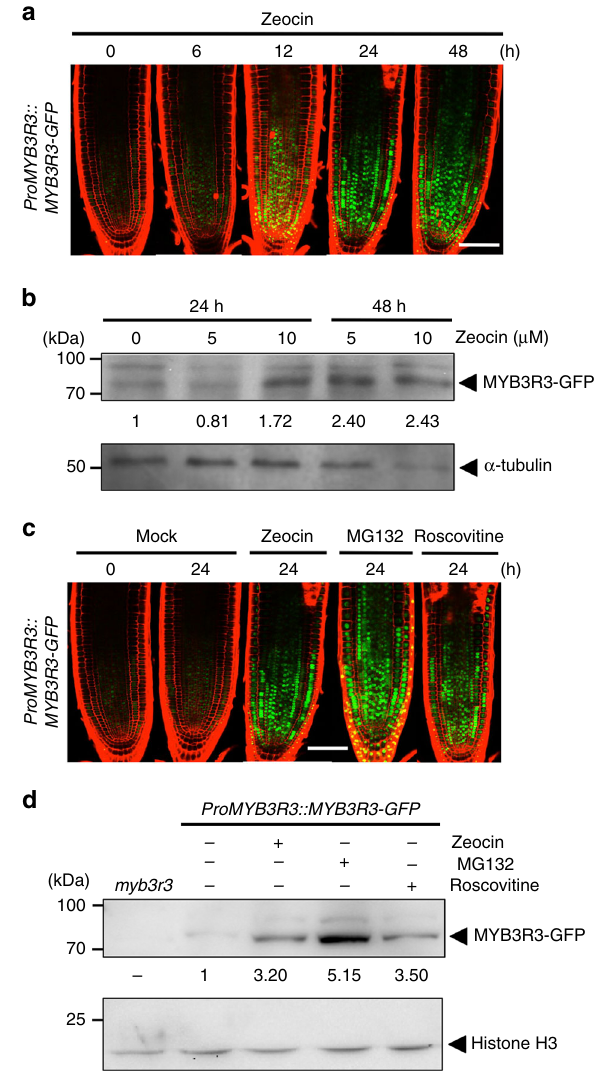
Fig. 2 MYB3R3 accumulation in the root tip. a , c Confocal microscopy images of root tips. Five-day-old myb3r3 seedlings harbouring ProMYB3R3:: MYB3R3-GFP were treated with 2 μ M zeocin for the indicated times a ,